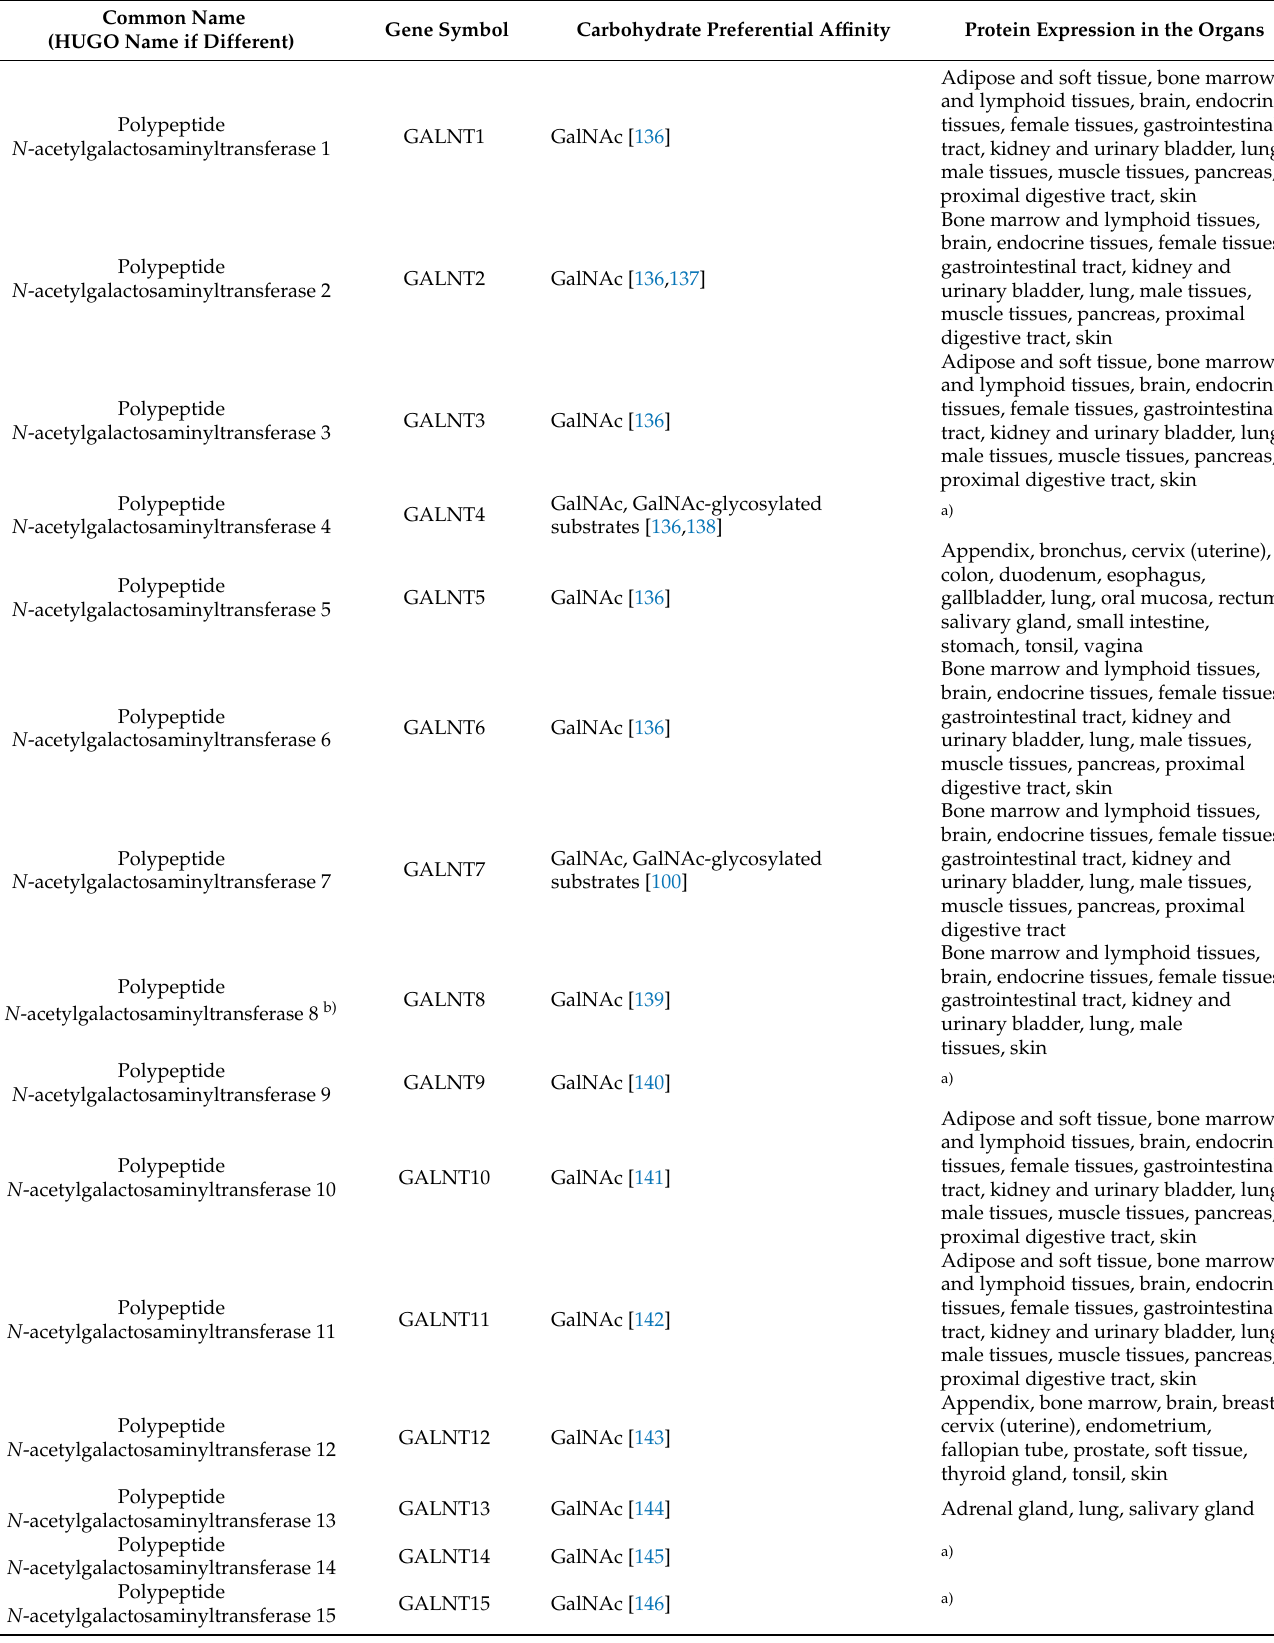
Table 10. Human R-type lectins, their carbohydrate ligands and protein expression in the